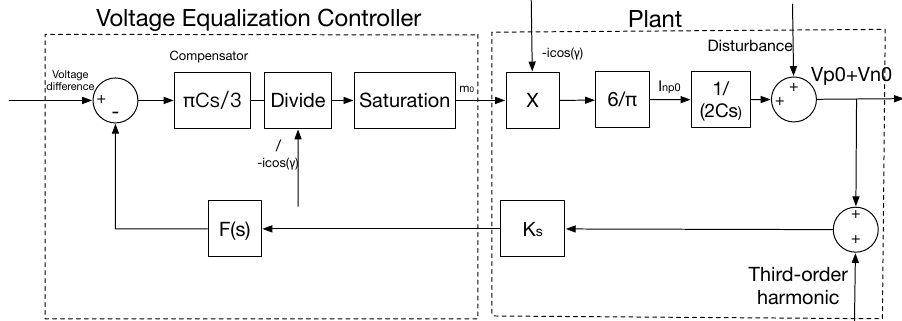
Figure 5. Control block diagram of voltage